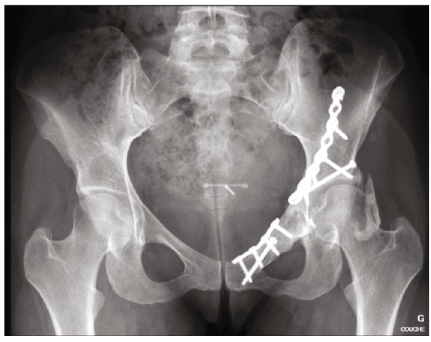
Figure 10: Plain fi lm at 4 years of follow-up showing healed osteotomy sites without signs of femoral head avascular necrosis or osteoarthritis. Note the presence of heterotopic ossi fi cation.